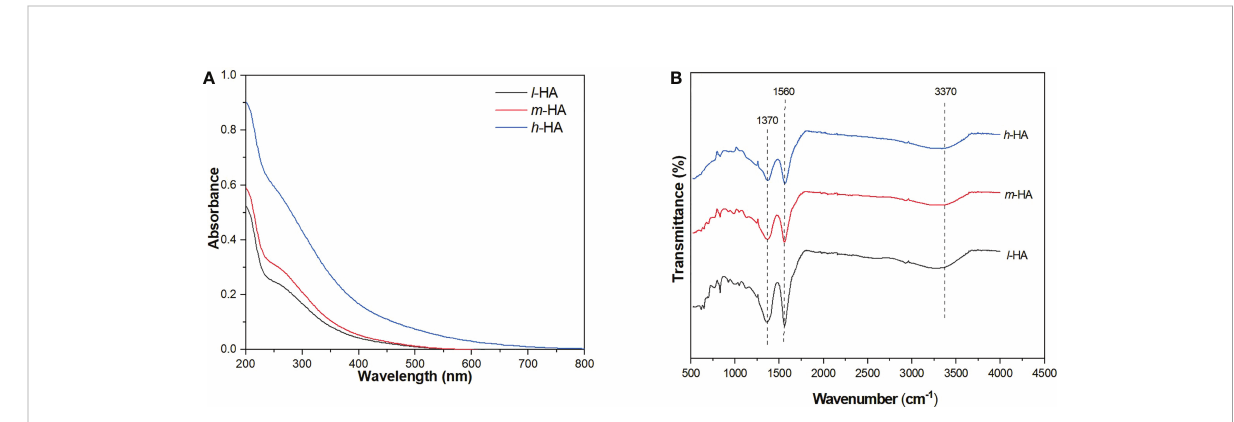
FIGURE 1 UV-Vis spectra (A) and FTIR spectra (B) of different HA